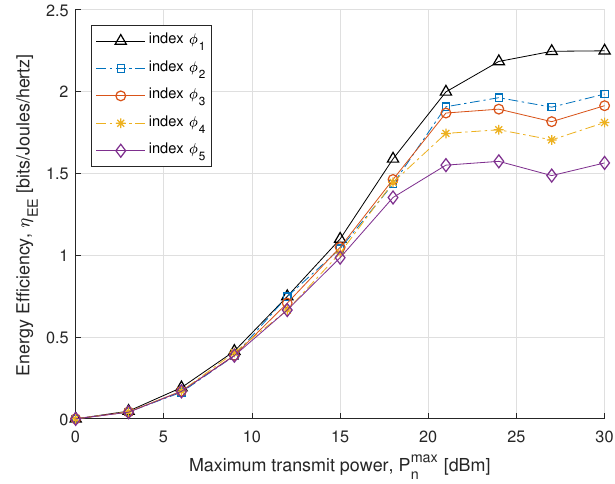
Figure 6. EE vs. transmit power.